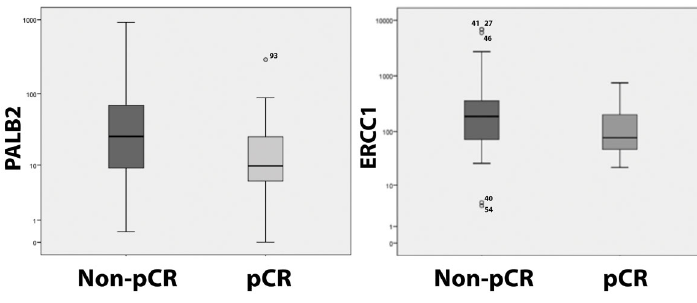
Figure 3. DNA repair gene expression of PALB2 and ERCC1 genes in pre-neoadjuvant chemotherapy biopsies by pathologic complete response (pCR). Data are reported as medians (interquartile range). P o 0.05 between groups for the two genes (Mann-Whitney